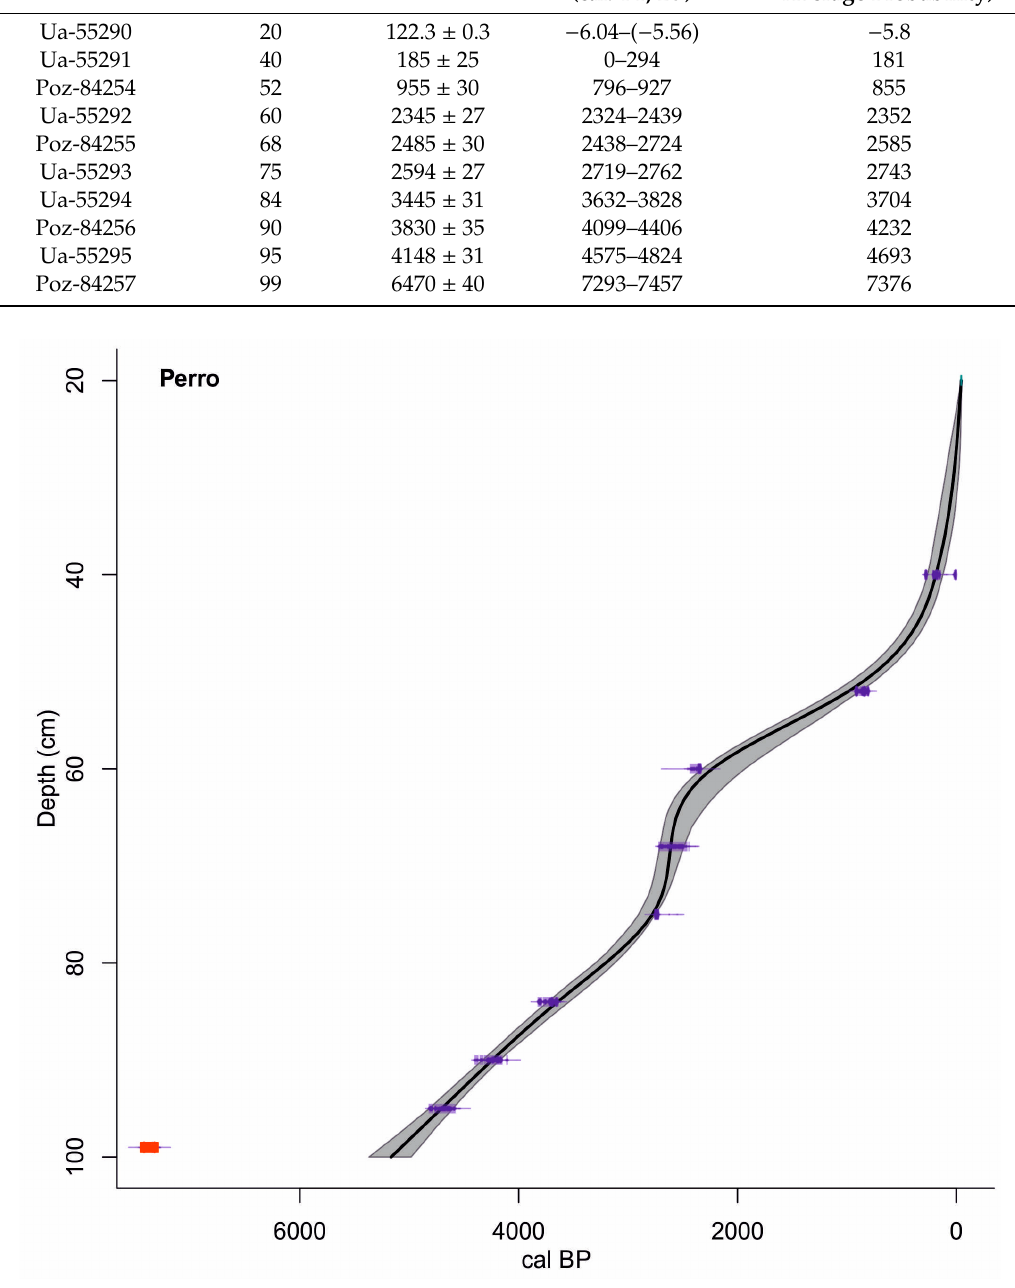
Figure 2. Age–depth model of El Perro mire. The red mark represents an outlier.